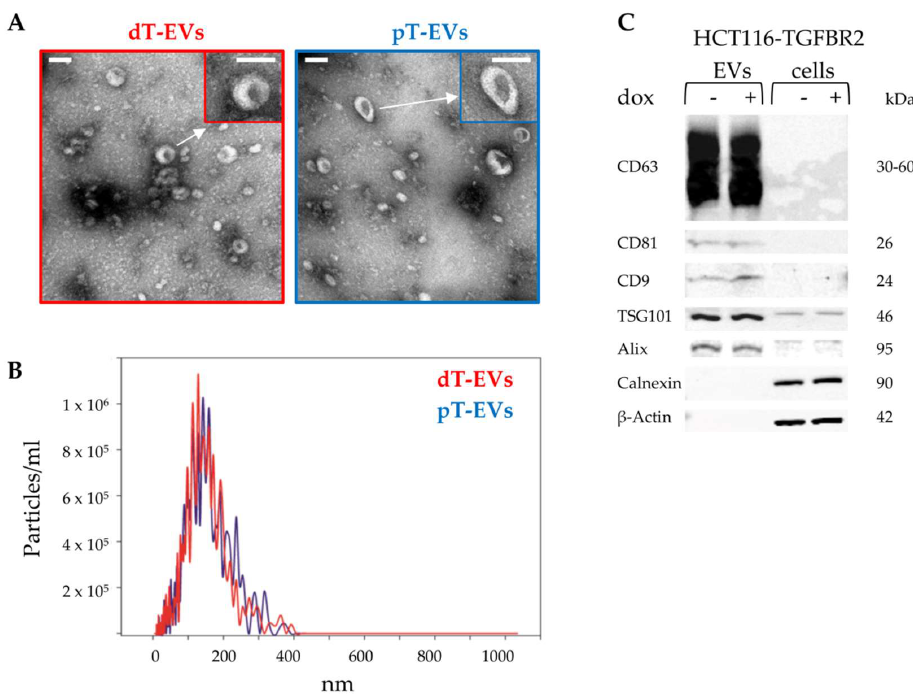
Figure 2. Identification of EVs. ( A ) Transmission electron microscopy (TEM) pictures visualized the morphology of isolated EVs. Scale bar: 100 nm. ( B ) Nanoparticle tracking analysis (NTA) revealed the size distribution and particle concentration of isolated EVs. ( C ) Western blot analysis confirmed EV-specific and cell-specific protein marker expression. Protein sizes are indicated.